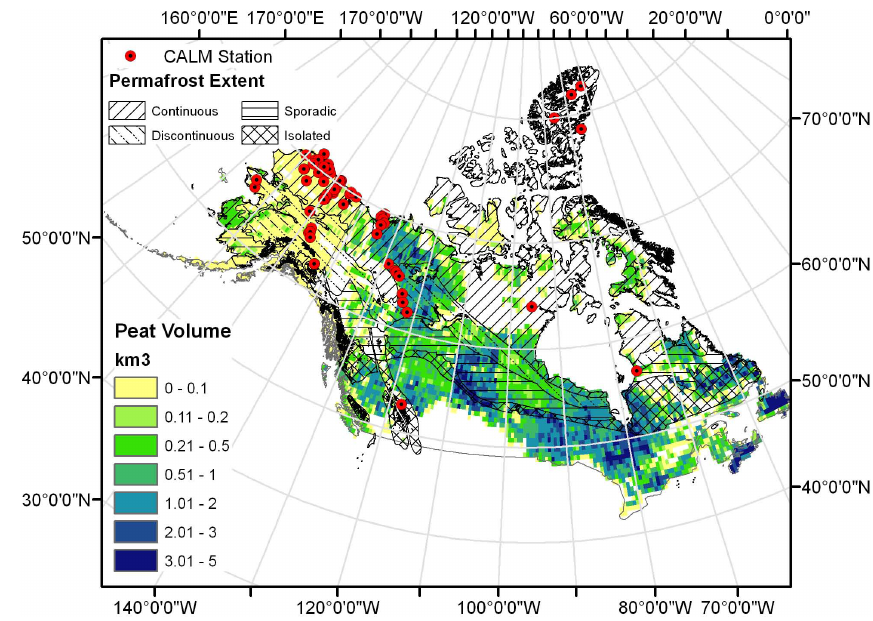
Fig. 2. Estimated peat volume (from the NSCD database) in each 30min grid cell, distribution of permafrost under contemporary conditions, and location of the CALM sites in the model domain. Permafrost classification is from Brown et al. (2001). Southern boundary defined by Tarnocai et al. (2009) soils